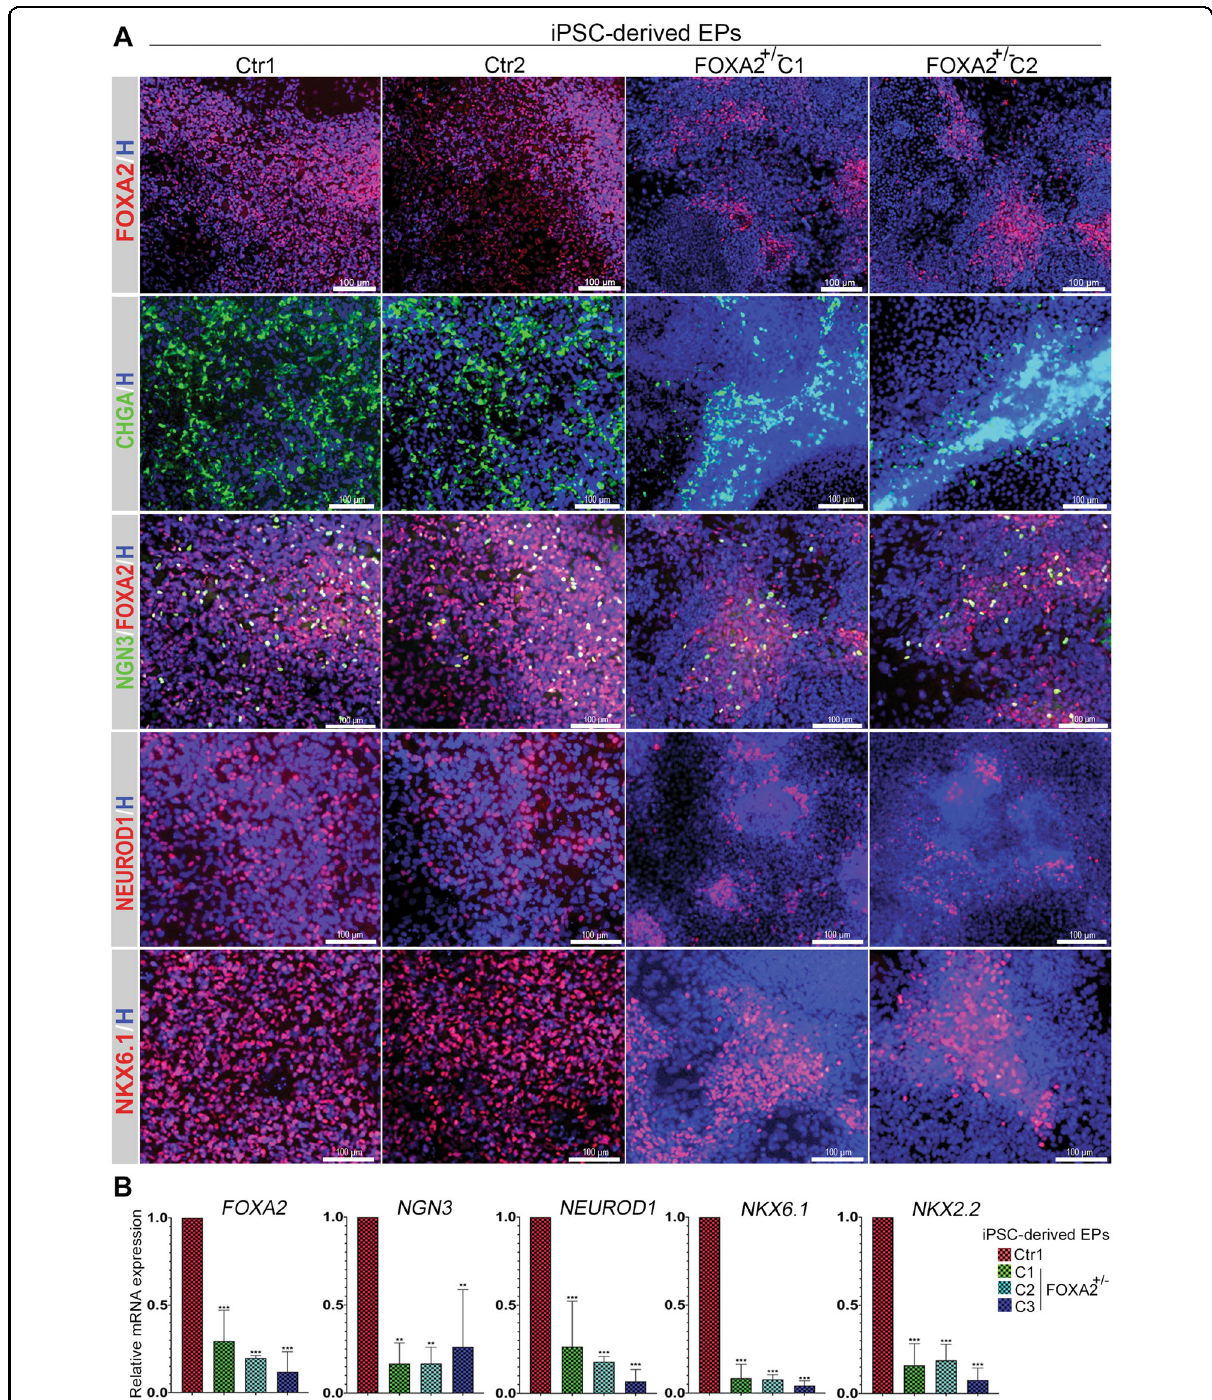
Fig. 3 Effect of FOXA2 haploinsuf fi ciency on pancreatic endocrine progenitors (EPs) differentiation. A Representative immuno fl uorescent images showing the expression of FOXA2, NGN3, CHGA, NEUROD1, and NKX6.1 in endocrine progenitors (EPs) derived from Ctr-iPSCs and FOXA2 + / − iPSCs. B Real-time PCR analysis for the expression of the key EPs markers, FOXA2 , NGN3 , CHGA , NEUROD1 , NKX6.1 , and NKX2.2 in the EPs derived from Ctr-iPSCs and FOXA2 + / − iPSCs. Data are represented as mean ± SD; * p < 0.05, ** p < 0.01, *** p <